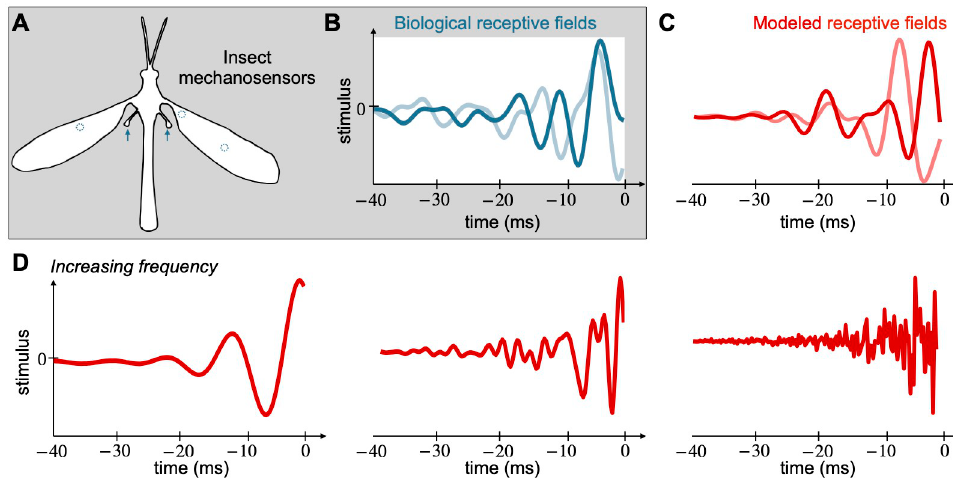
Fig 2. Random receptive field model of insect mechanosensors. (A) Diagram of the the cranefly, Tipula hespera . Locations of the mechanosensors, campaniform sensilla, are marked in blue on the wings and halteres. (B) Two receptive fields of campaniform sensilla are shown in blue. They are smooth, oscillatory, and decay over time. We model them as random samples from distributions parameterized by frequency and decay parameters. Data are from the hawkmoth [14]; cranefly sensilla have similar responses [13]. (C) Two random samples from the model distribution are shown in red. (D) The smoothness of the receptive fields is controlled by the frequency parameter. The decay parameter controls the rate of decay from the origin (not